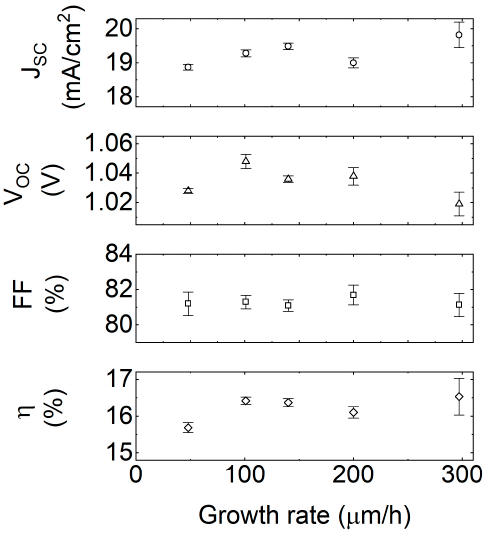
Figure 5. Cell parameters for GaAs solar cells grown at various growth rates with an input V/III ratio of 6 under a H 2 carrier gas ( 𝐻 (cid:2870)(cid:3002)(cid:3046)(cid:3009)(cid:2871) ) flow rate of 10 slm.